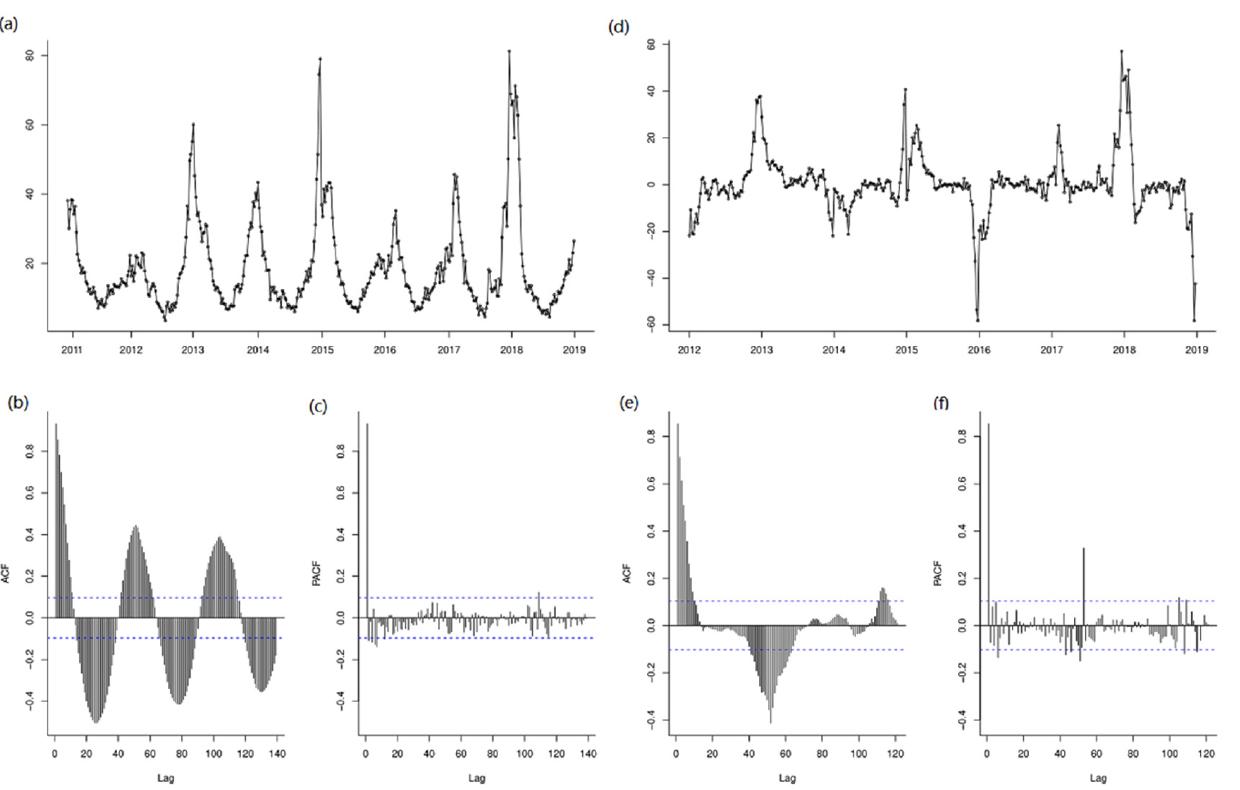
Figure 5. The time diagram, ACF and PACF graphs for estimating the parameter: ( a ) the time diagram of ILI incidence after one-order seasonal difference data, ( b ) the ACF graph of the raw data (d = 0, D = 0), ( c ) the PACF graph of the raw data (d = 0, D = 0), ( d ) the time diagram of ILI incidence a, ( e ) the ACF graph of one-order seasonal difference data (d = 0 and D = 1), ( f ) the PACF graph of one-order seasonal difference data (d = 0 and D = 1).